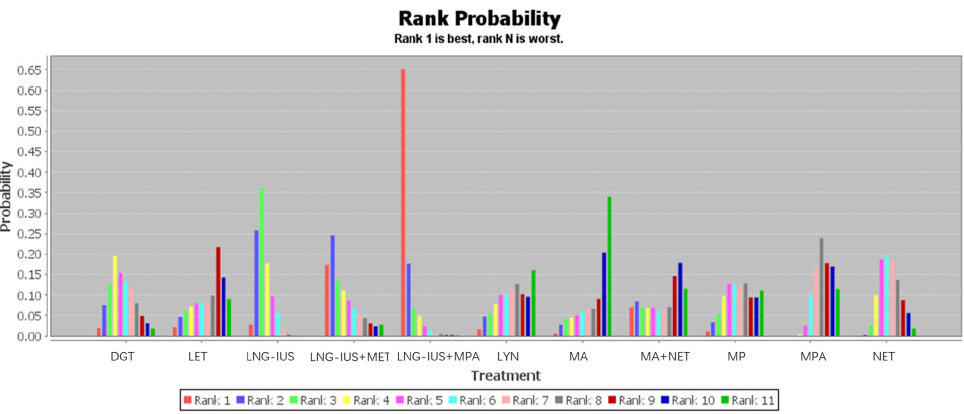
Figure 6. Ranking of the 11 treatments for endometrial hyperplasia based on regression rate. Rank 1 indicates the best regression rate and rank 11 the worst.